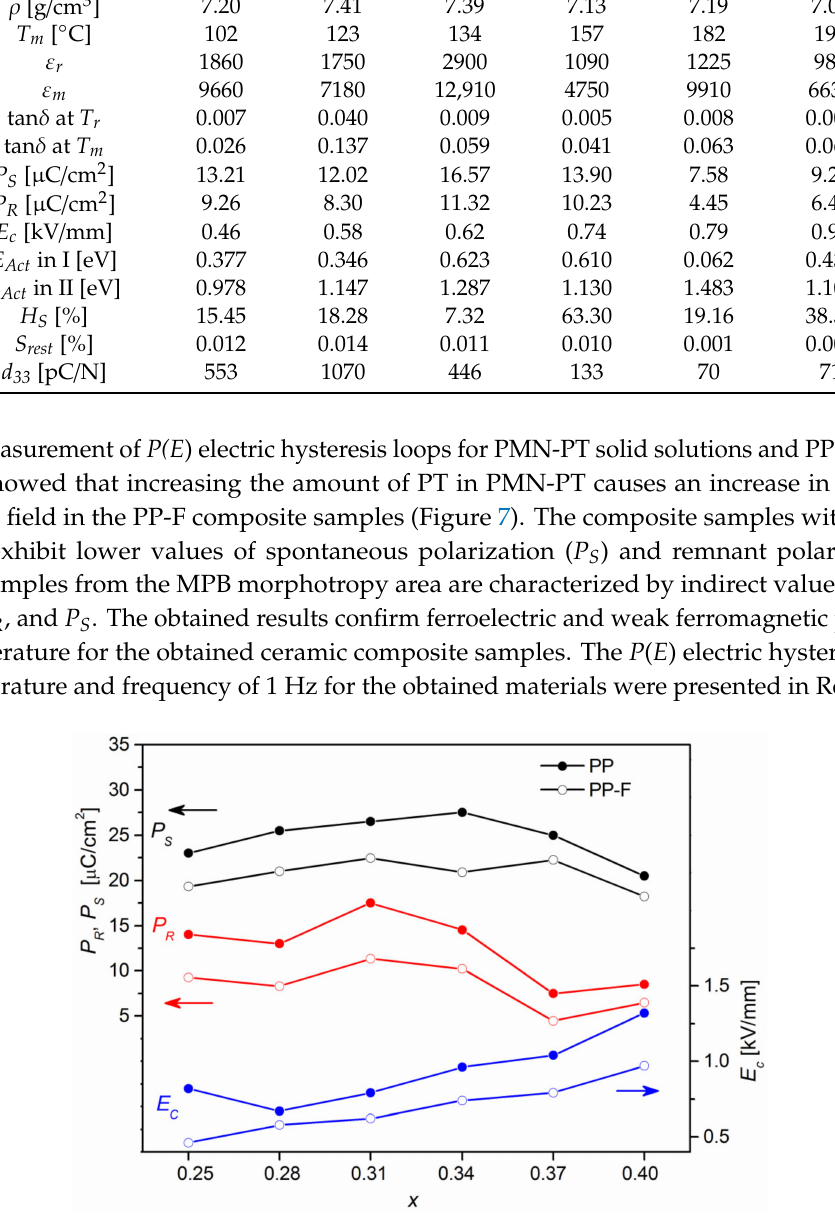
Figure 7. Dependence of remnant polarization P R , spontaneous polarization P S , and coercive field E c of the (1 − x )PMN- x PT with x = 0.25, 0.28, 0.31, 0.34, 0.37,